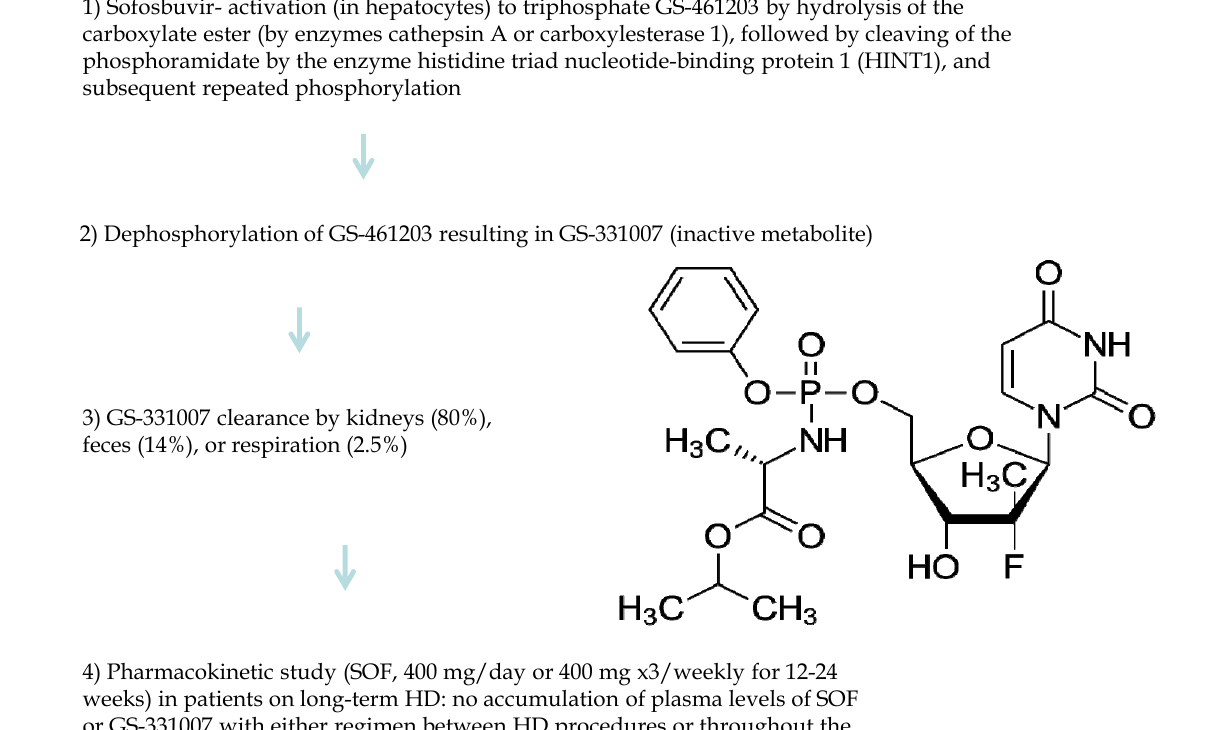
Figure 2. Sofosbuvir: metabolism in advanced kidney impairment and structure.